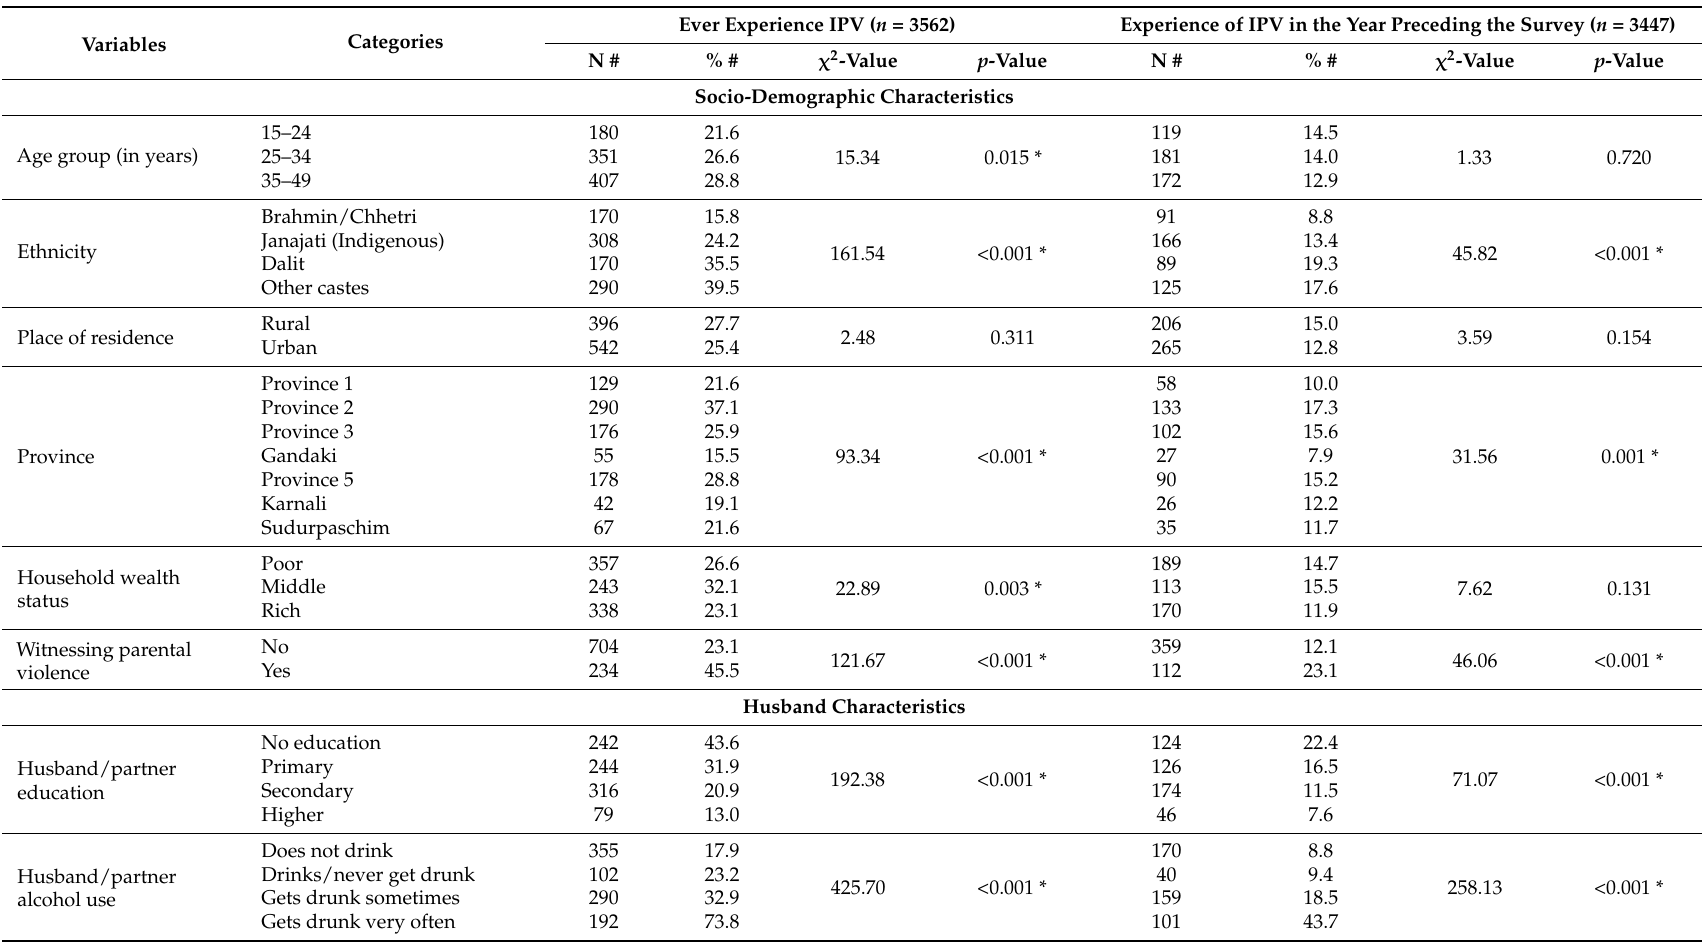
Table 5. Experience of intimate partner violence ‘ever’ and ‘in the year preceding the survey’ by background characteristics.